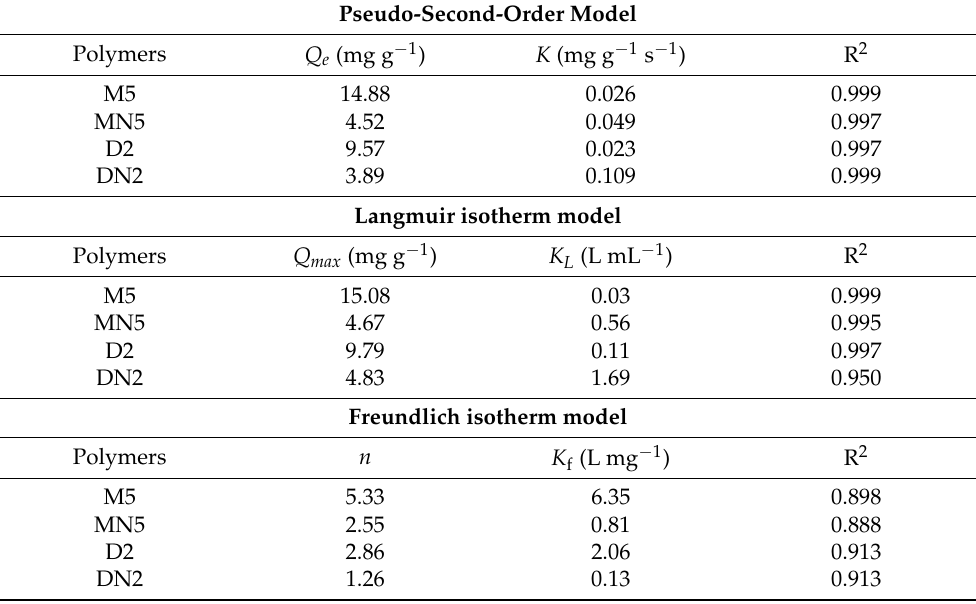
Figure 6. ( A ) Kinetic adsorption of the polymers; ( B ) linear fitting of the plot of t / Q vs. t . Table 3. Pseudo-second-order, Langmuir, and Freundlich model parameters for the binding of ABM on MIPs and